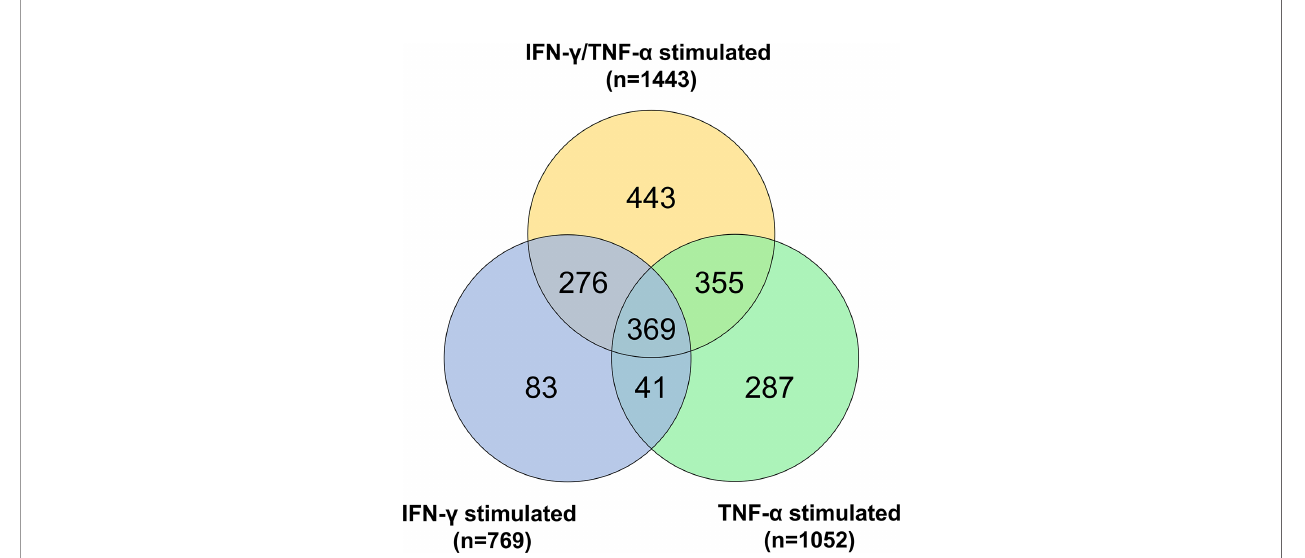
FIGURE 7 | Gene expression analysis on AC-16 cardiomyocytes. Cells were stimulated with IFN- g (10 ng/ml) or TNF- a (5 ng/ml) or IFN- g + TNF- a during 1 or 6 or 12 or 24 or 48h. On cardiomyocytes stimulated with TNF- a 1052 DEGs were detected whereas on cardiomyocytes stimulated with IFN- g 769 DEGs were detected. Finally, on cardiomyocytes stimulated 48h with IFN- g + TNF- a 1443 DEGs were detected. Venn diagram describes the DEGs shared by the various stimulations. Each stimulation was performed 4 times